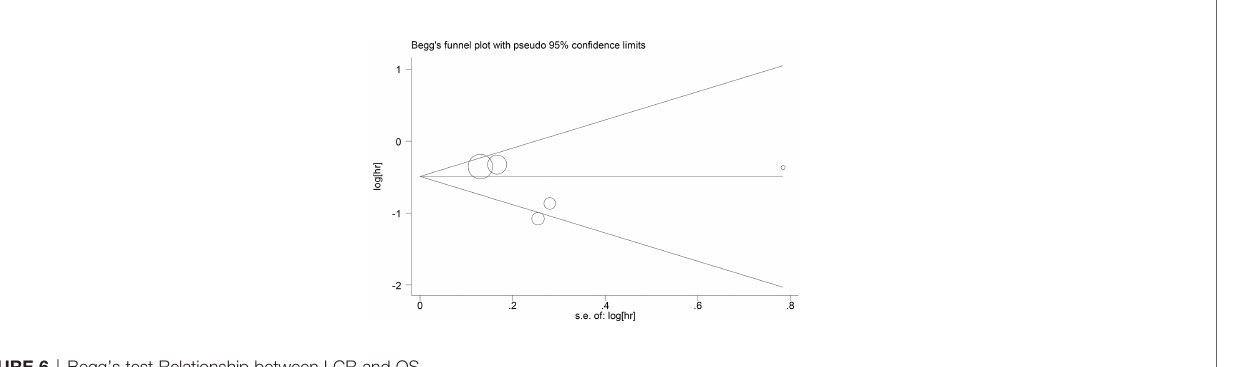
FIGURE 6 | Begg ’ s test Relationship between LCR